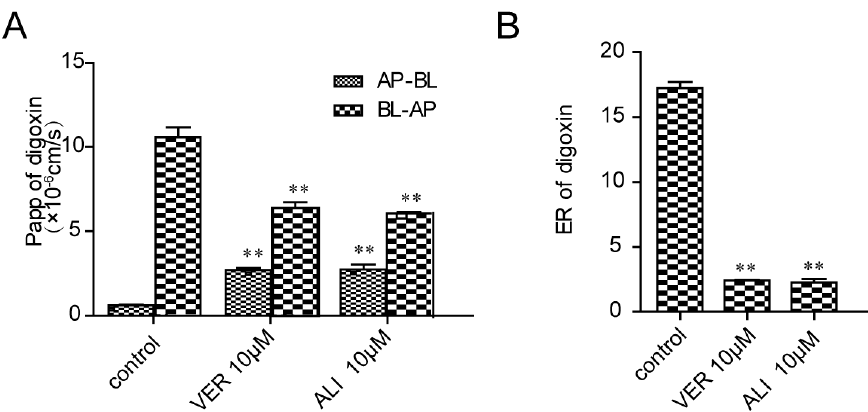
Figure 3. Effect of 10 μ M ALI on the two-way transport of P-gp substrate digoxin across Caco-2 monolayers ( A ) Papp BL-AP and Papp AP-BL of digoxin; ( B ) the efflux ratio of digoxin. Results were means ˘ SEM of three separate experiments. Significance level ** p < 0.01.